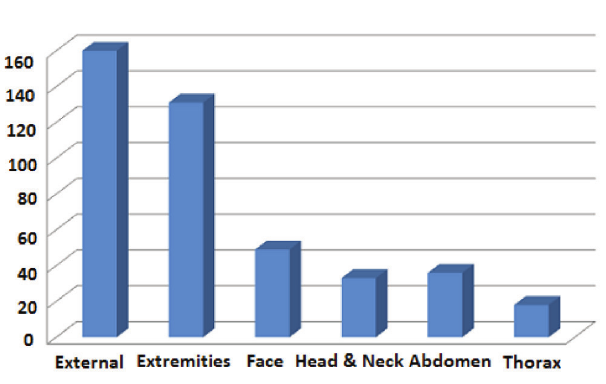
Figure 1. Top 6 Most Commonly Injured Organs (Based on